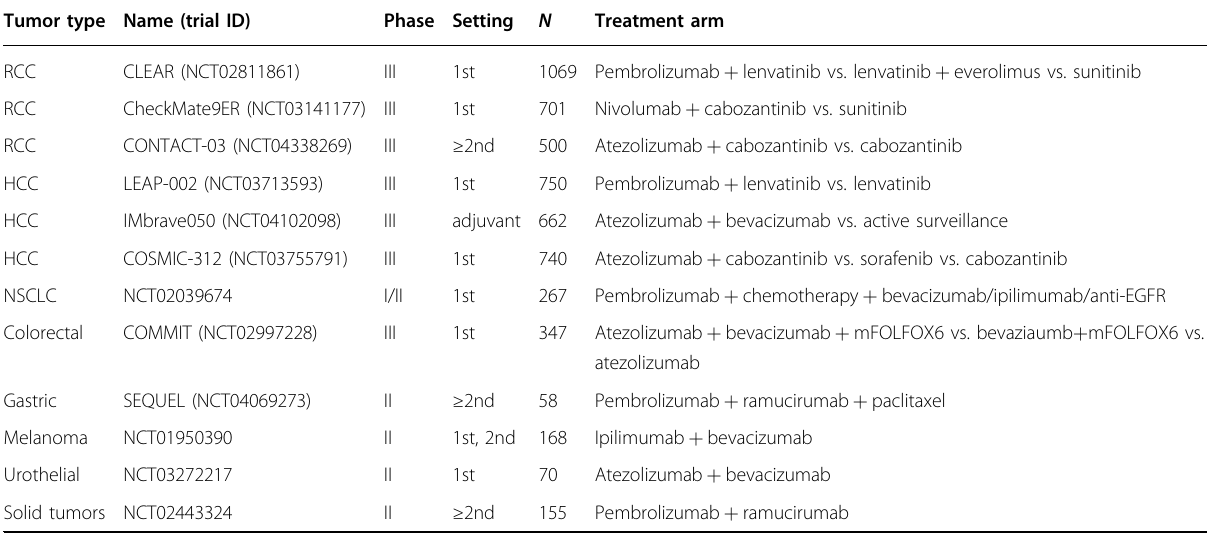
Table 1 Ongoing clinical trials investigating combined anti-angiogenic therapy and immune checkpoint inhibitors. Tumor type Name (trial